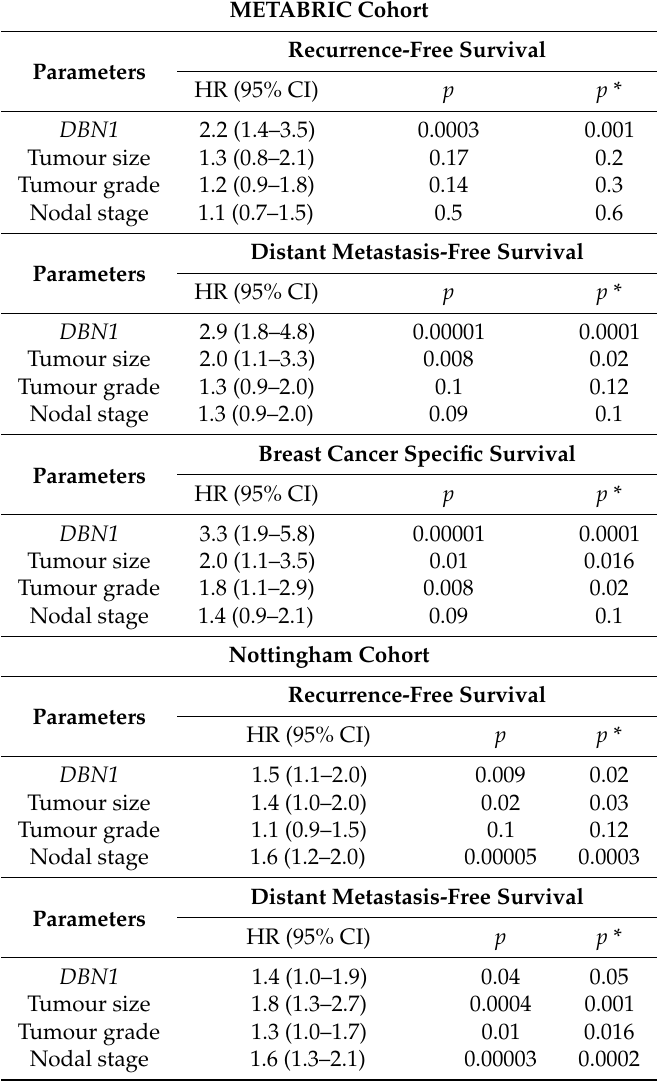
Multivariate cox analysis of the associations between DBN1 expression and the clinicopathological parameters in all luminal breast cancer irrespective of